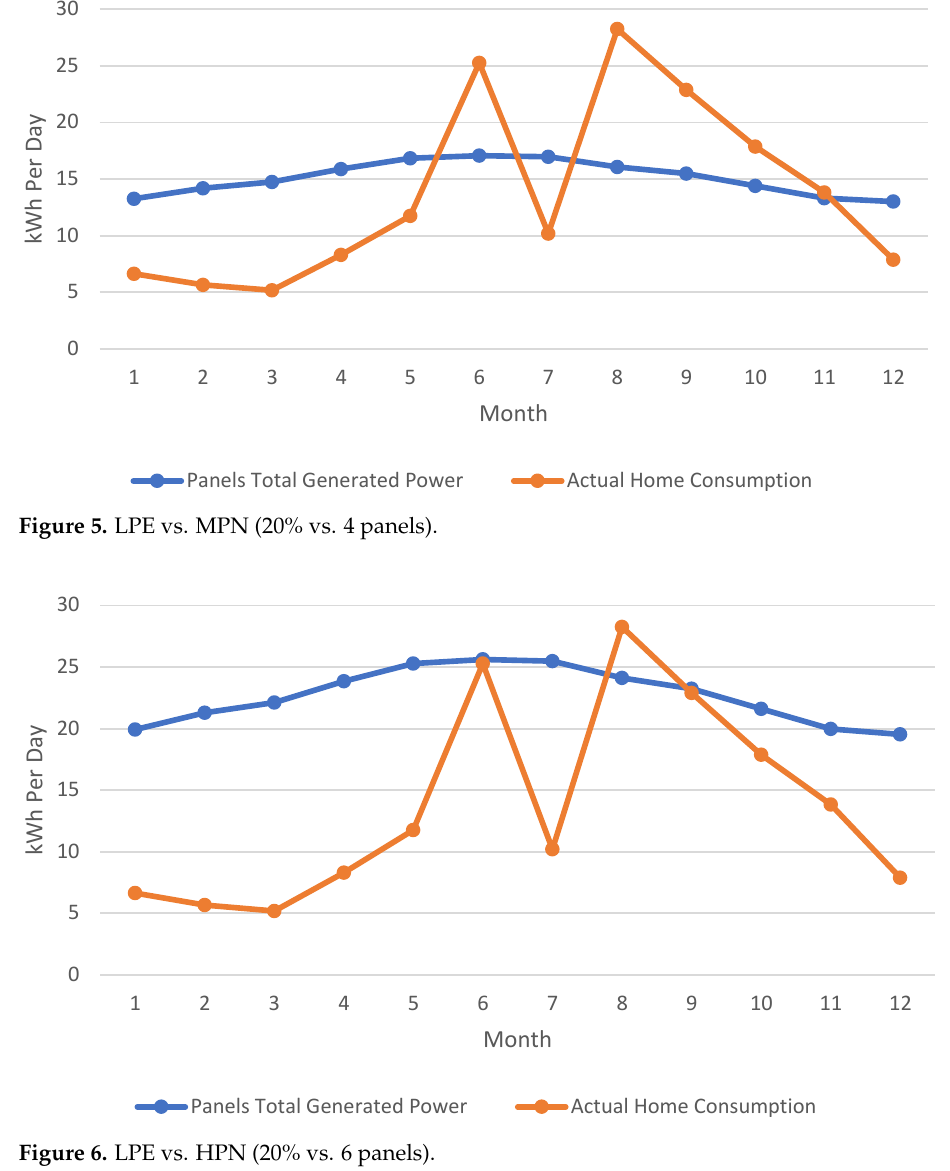
Figure 6. LPE vs. HPN (20% vs. 6 panels) .